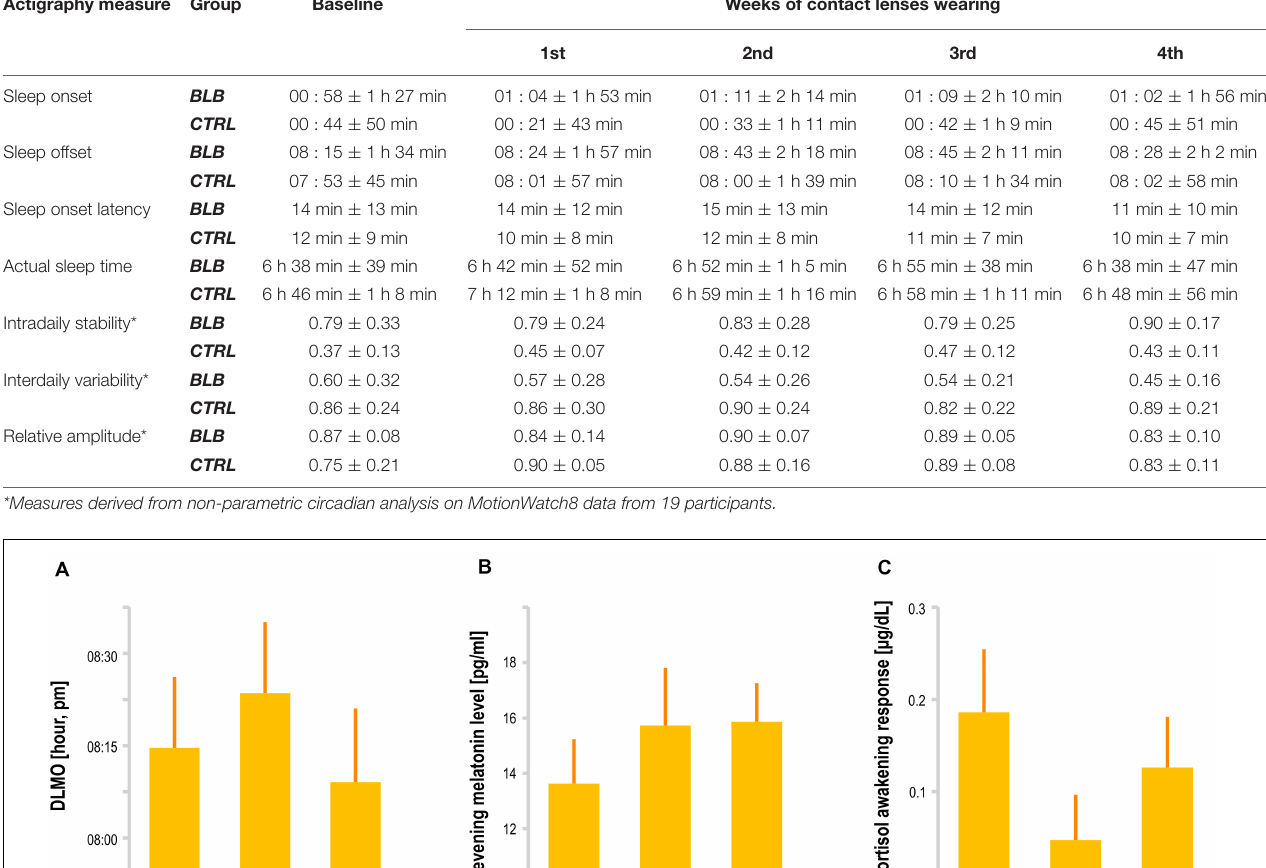
TABLE 2 | Actigraphy-derived sleep parameters in baseline and four weeks of experimental condition for the blue light blocked (BLB) and control (CTRL) group. Actigraphy measure Group Baseline Weeks of contact lenses wearing